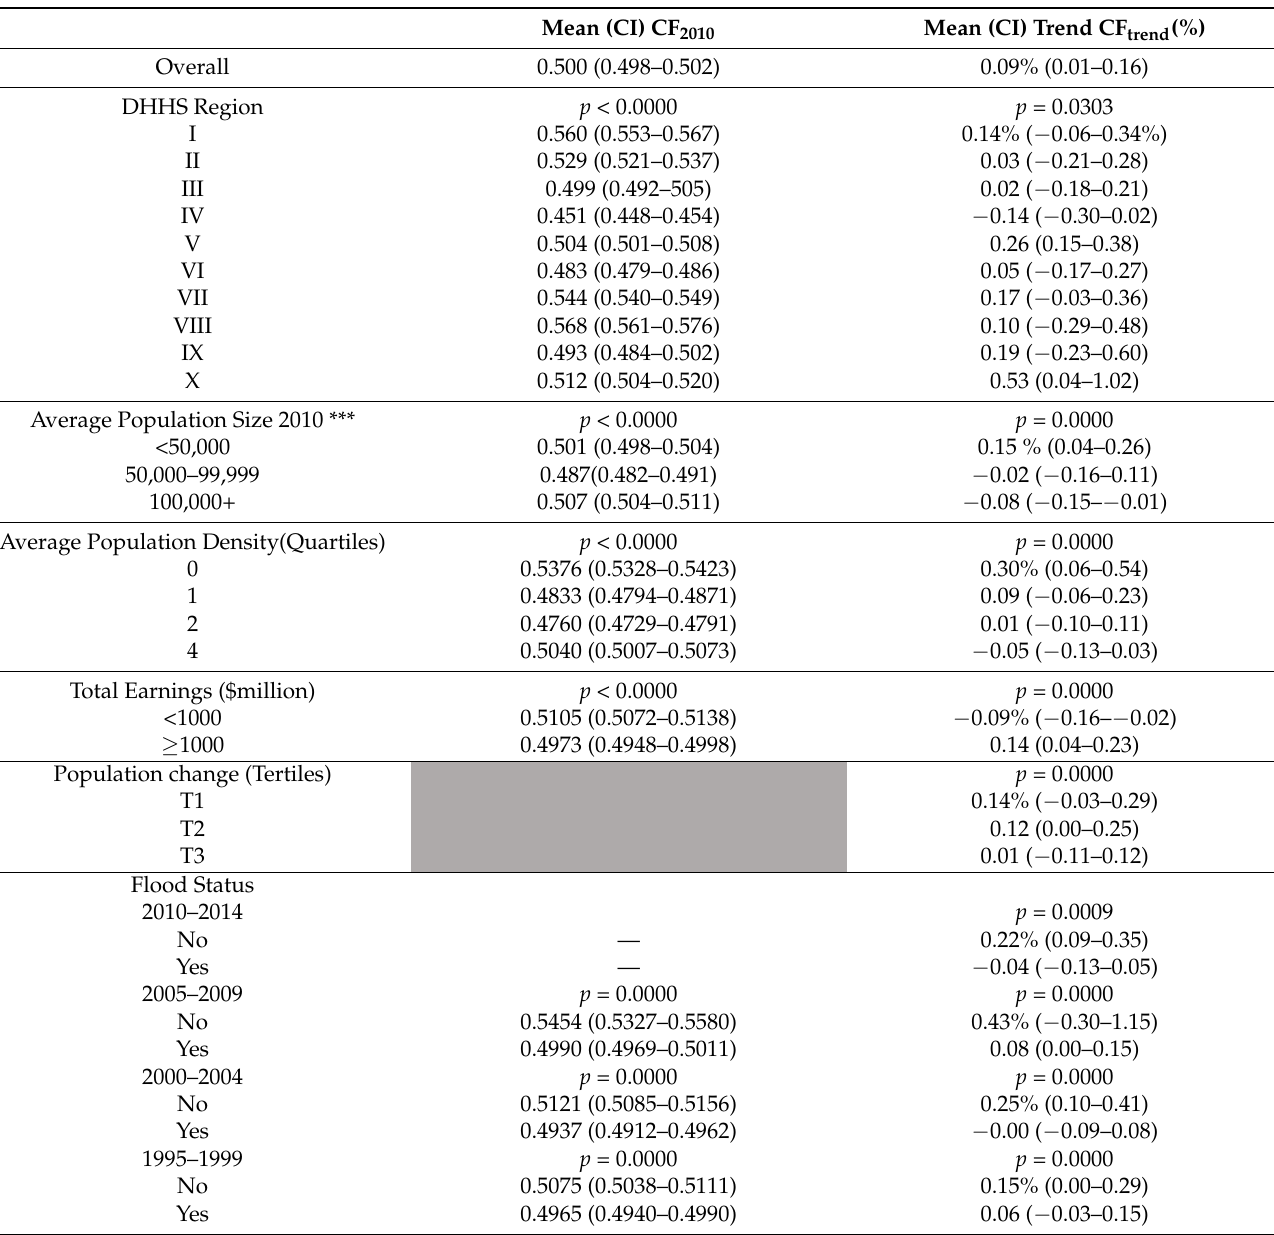
Table 3. Mean baseline CF (2010) and CF Trend (2010–2015), all US